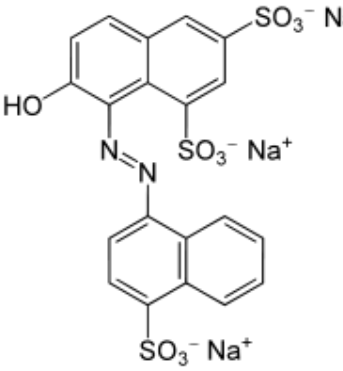
Figure 1. Structural formula of Ponceau 4R (E124).